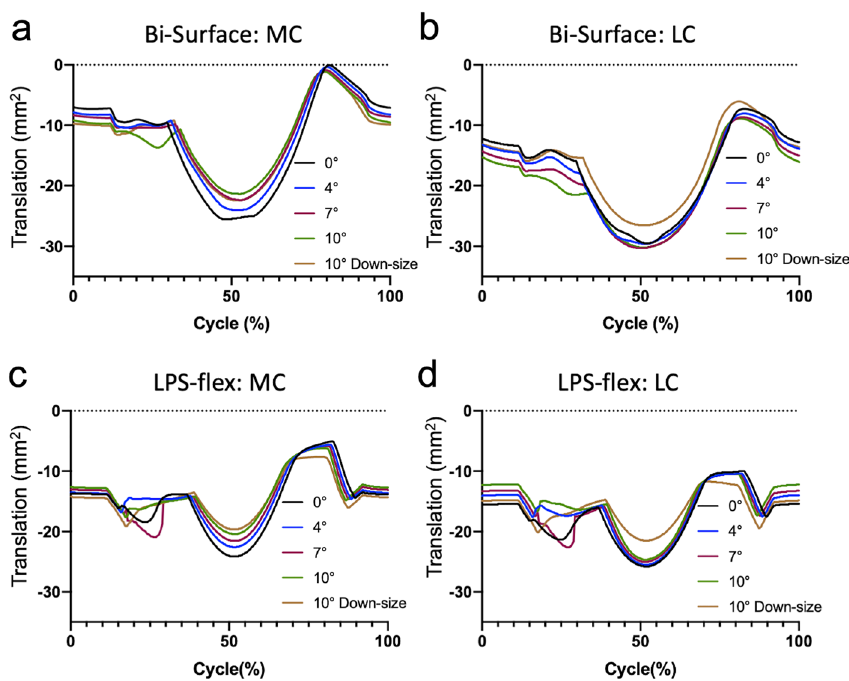
Figure 2. Antero-posterior translation of the facet centre of the Bi-Surface Knee ( a : MC: medial compartment and b : LC lateral compartment) and the LPS-flex ( c : MC, d :